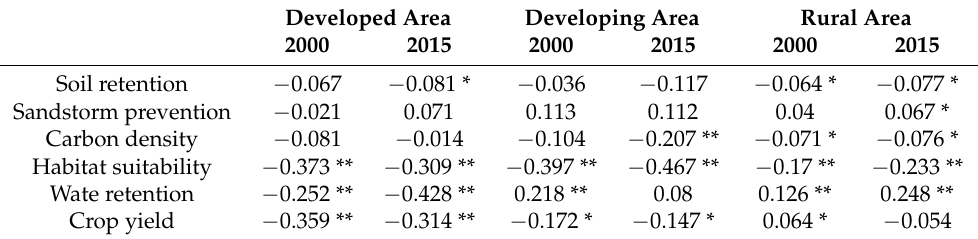
Table 5. The correlation coefficients of ESs with urbanization in different urban areas in 2000 and 2015. Developed